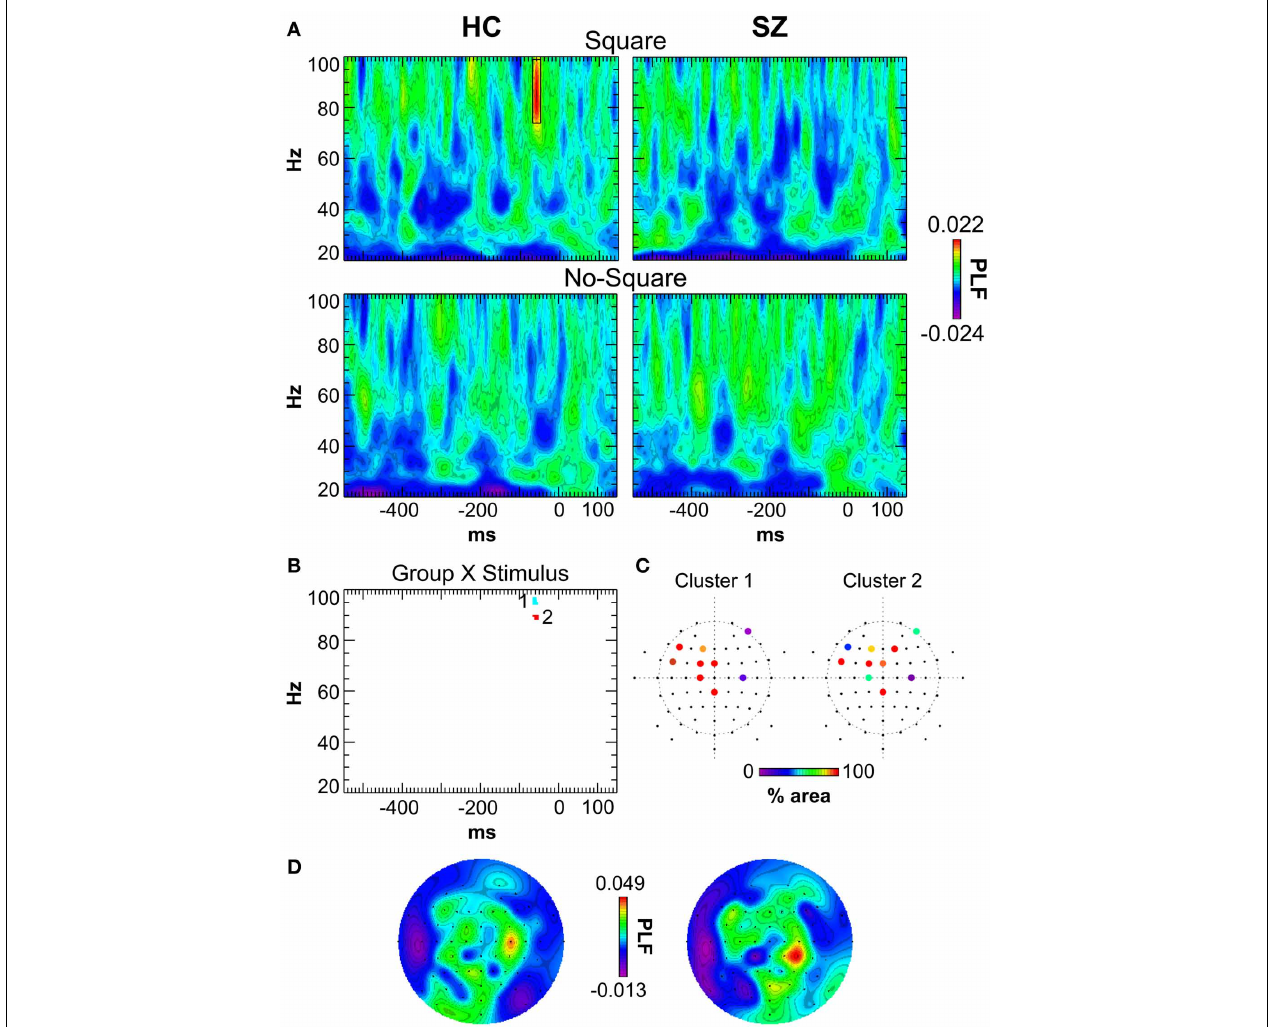
FIGURE 4 | Response-locked TF maps of PLF. (A) TF maps averaged across all scalp electrodes for the Square and No-Square conditions for each group. The response-locked γ oscillation in the HC/Square condition is outlined ( − 69 to − 50ms, 74–99Hz). (B) Group X Stimulus statistical map. The clusters of significant TF elements are indicated. (C) Electrodes contributing to each cluster. The percent area of each